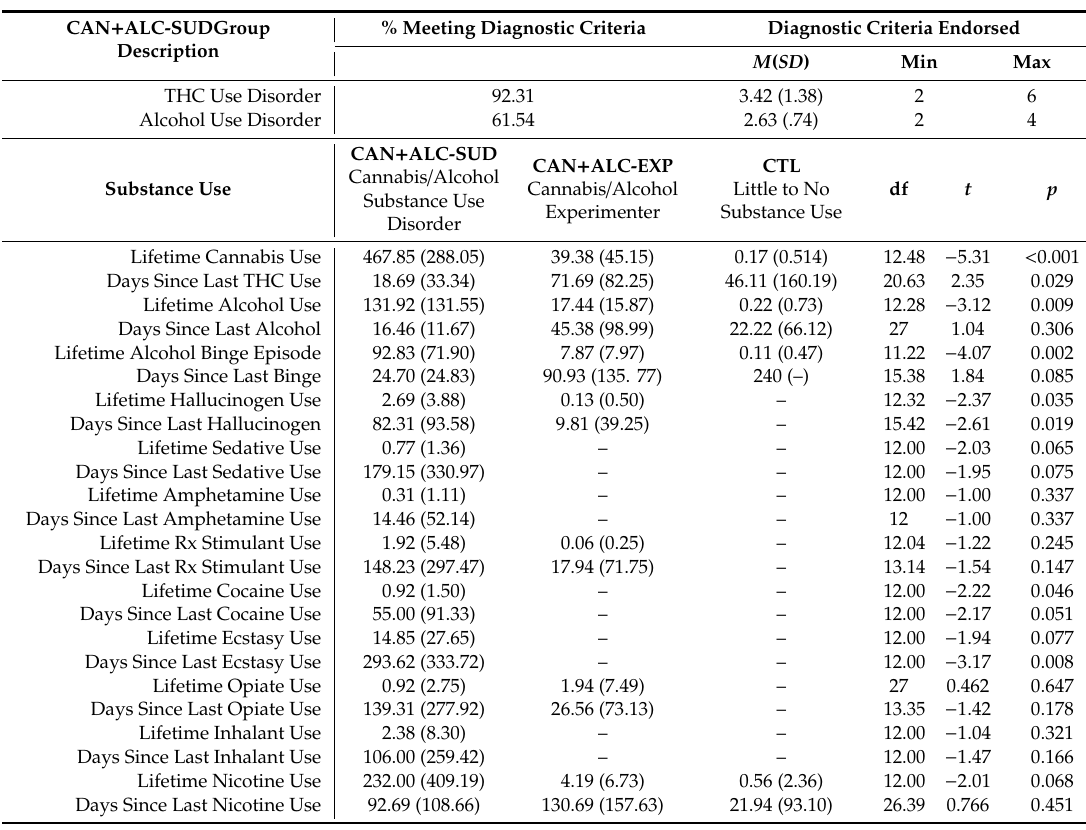
Table 1. Characteristics of Substance